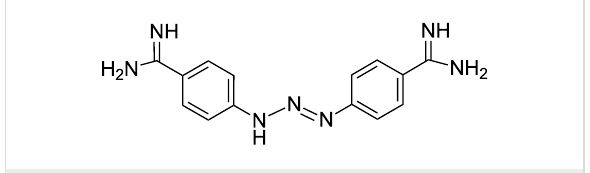
Figure 11: Structure of diminazene.